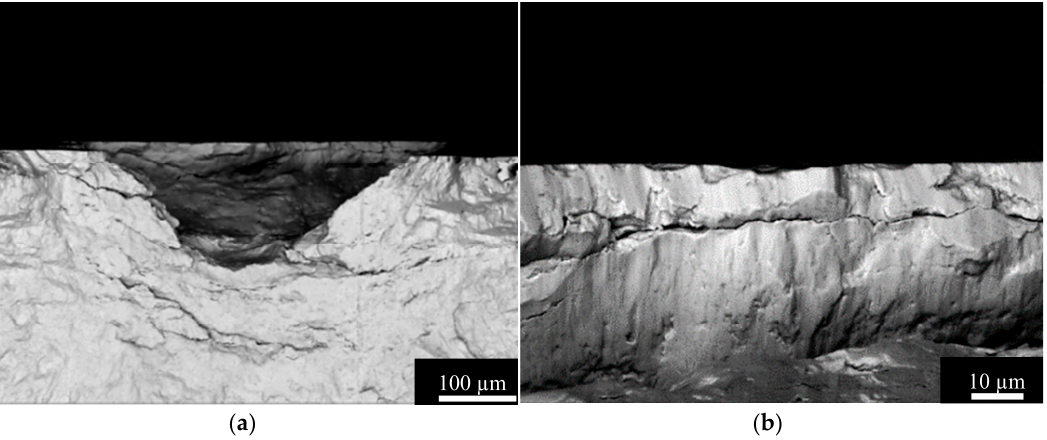
Figure 1. Example of SEM images of cross section of surface fracture on a bearing racetrack: ( a ) general view and ( b ) detail of sub-surface cracks [30].